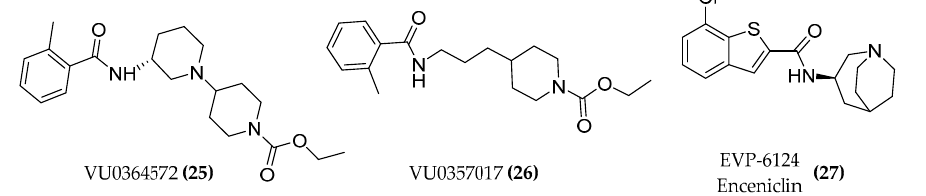
Figure 10. Structures of M1 lead candidates.